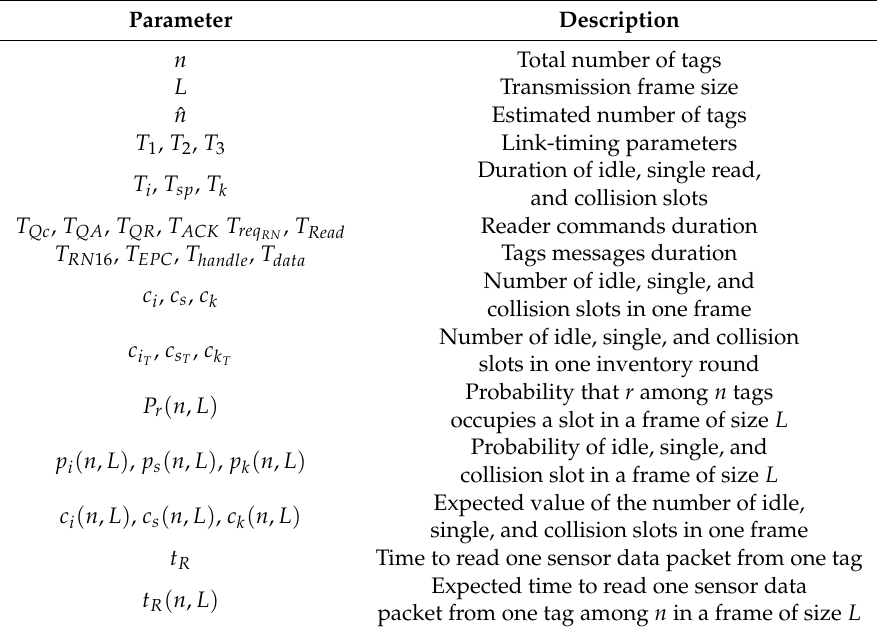
Table 3. Main parameters used in the frame update analysis of this work.